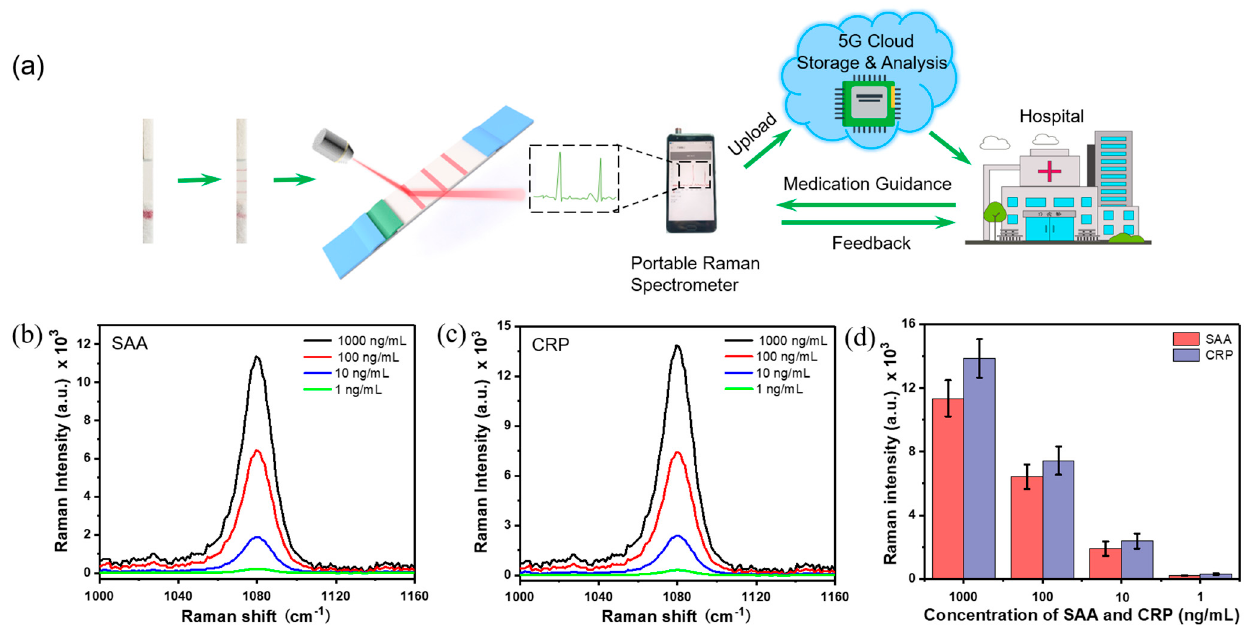
Figure 5. ( a ) Schematic illustration of telemedicine based on a portable Raman spectrometer after LFA. Averaged Raman Scheme 1079 cm − 1 of two test lines for different concentrations of ( b ) SAA and ( c ) CRP measured by a portable Raman spectrometer. ( d ) The corresponding Raman intensities at 1079 cm − 1 of two test lines.